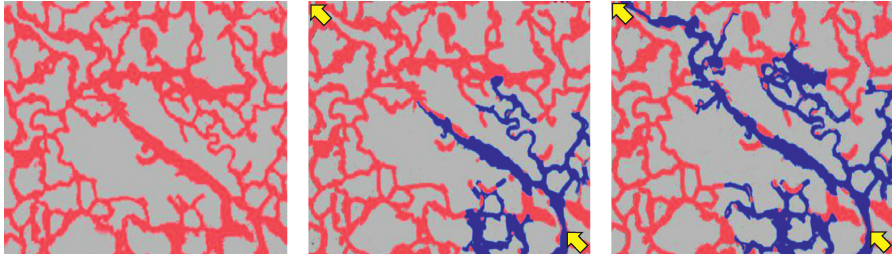
Figure 6: Schematic diagram of the early, middle, and late stages of water injection in fractured-porous reservoirs.